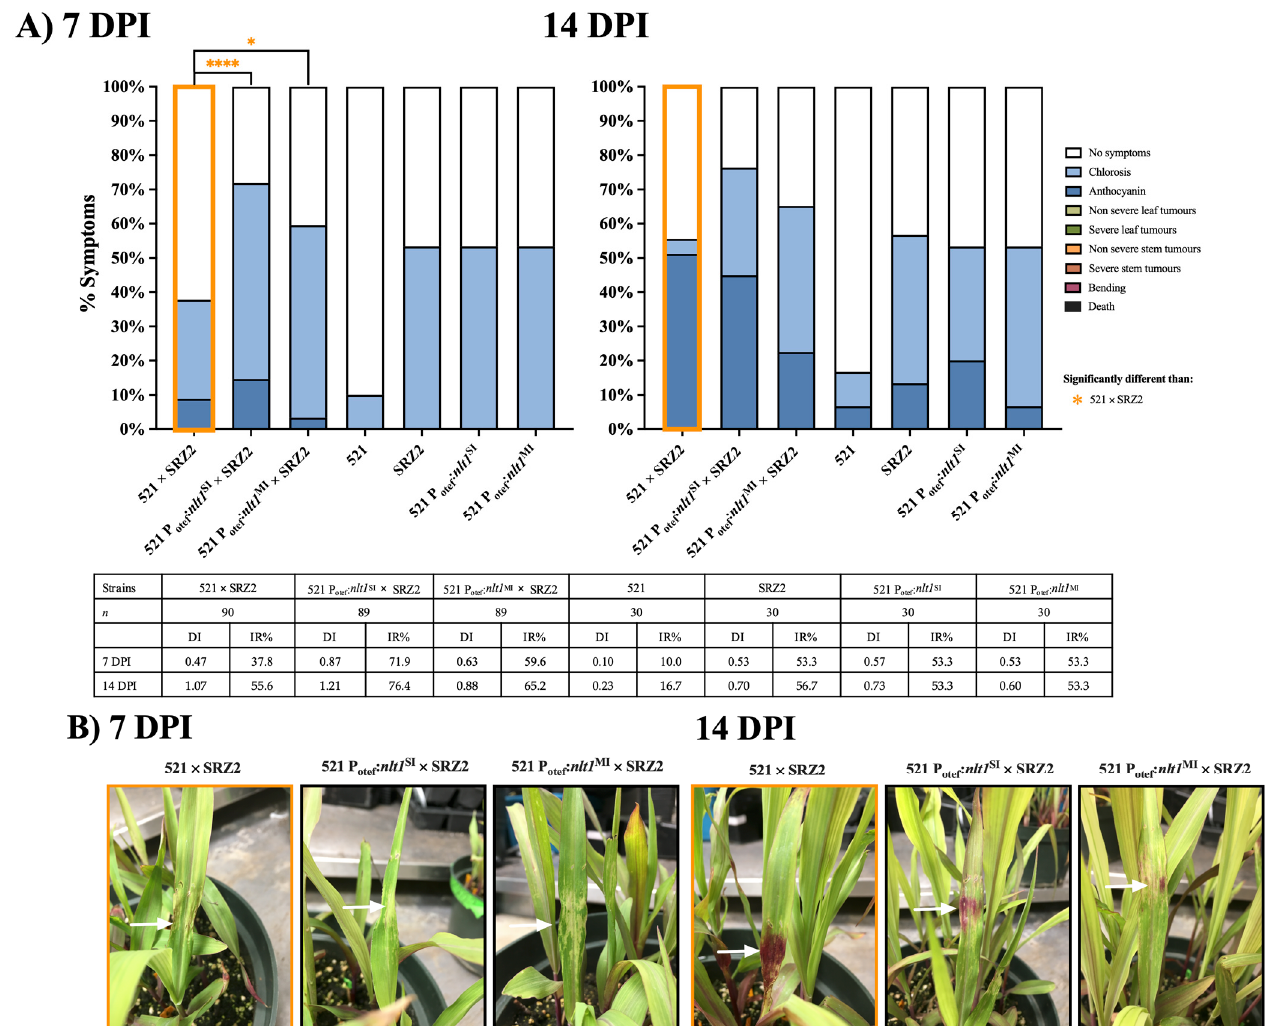
Figure 8. Infections with hybrids constitutively expressing nlt1 produced pronounced chlorosis at 7 and 14 DPI. ( A ) Colored bars represent the percentage of plants that developed a scored symptom. The table presents the number of plants infected ( n ), disease index (DI), and infection rate (IR). ( B ) Representative symptoms, indicated by the arrows, for 521 × SRZ2 infections are chlorosis at 7 DPI and anthocyanin at 14 DPI, for 521 P otef : nlt1 SI × SRZ2 infections are chlorosis at 7 DPI and anthocyanin at 14 DPI, and for 521 P otef : nlt1 MI × SRZ2 infections are chlorosis at 7 DPI and chlorosis + anthocyanin at 14 DPI. Two separate experiments were conducted, and the combined results are presented. Statistical differences were calculated comparing the hybrid to each parental dikaryon (* = p < 0.05; **** = p < 0.0001).